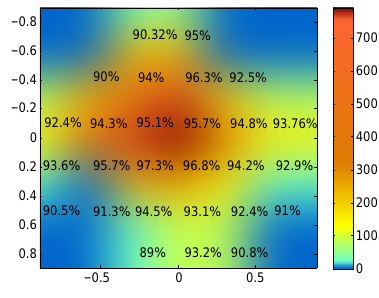
Fig. 9 Success of facial landmark localization in different pose-spaces for the 3DFEP database. times larger than the errors for the V-based